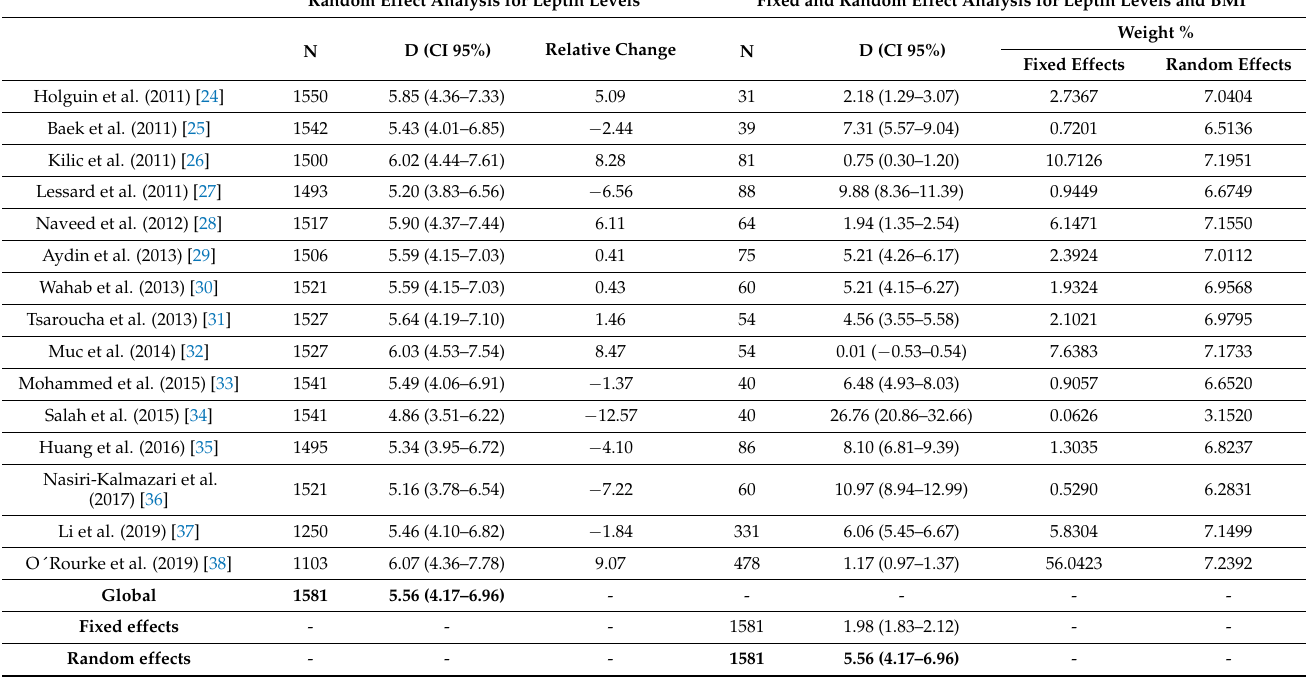
Table 3. Results from random effect analysis for leptin levels, and from fixed and random effect analysis for leptin levels and